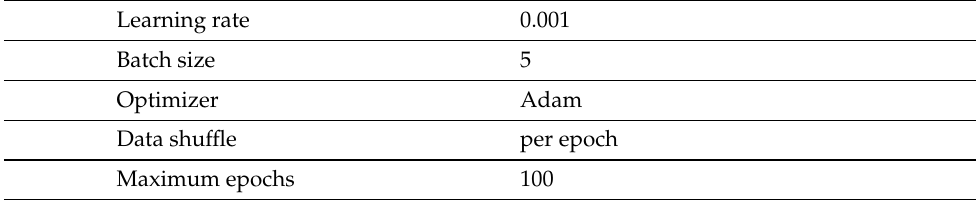
Table 1. Summary of hyperparameters for the proposed 1DCNN